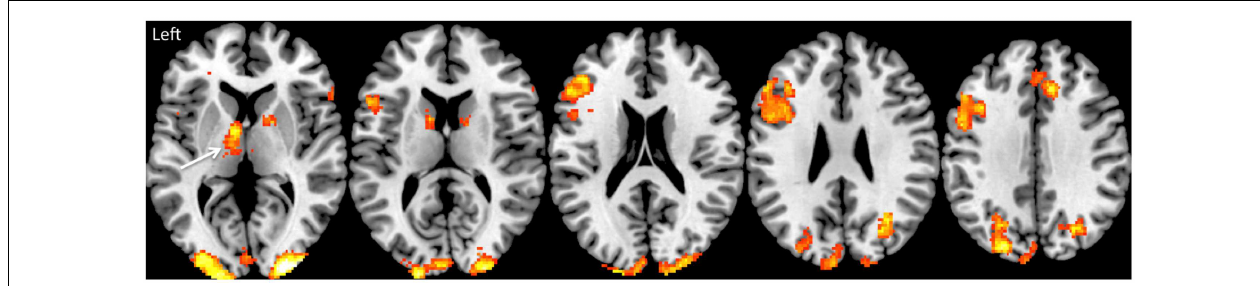
has revealed thalamic dysfunction on a group level (23, 24), see Figure 1